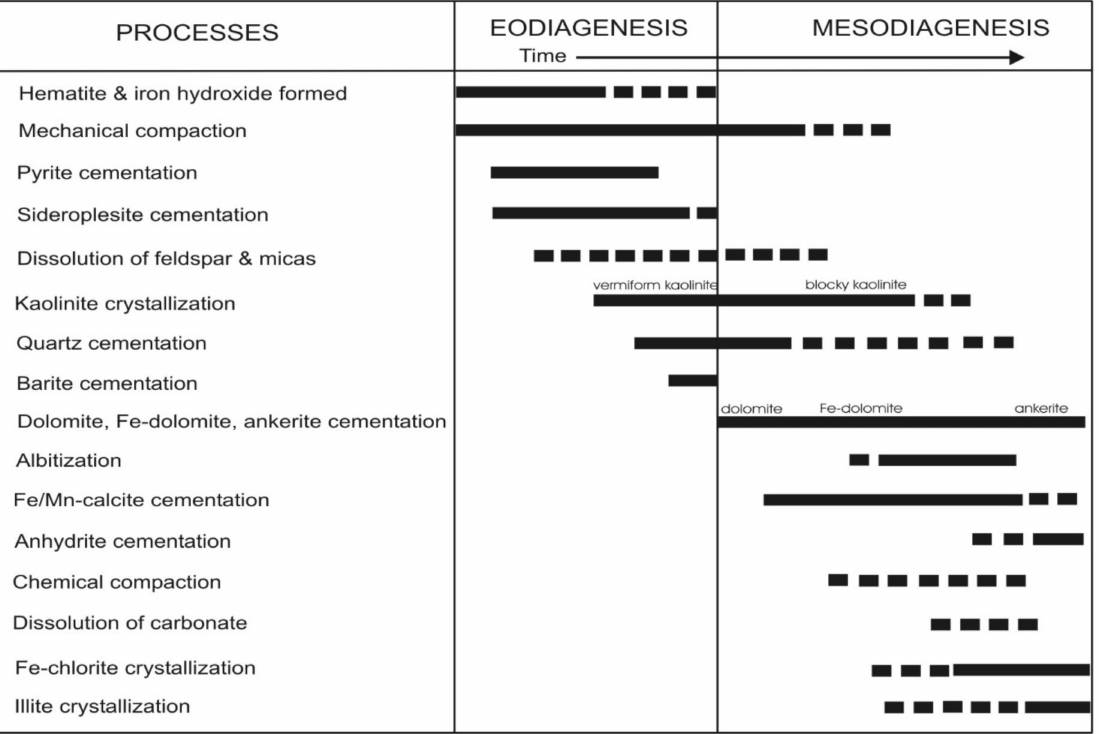
Figure 13. The synoptic paragenetic sequence of the Carboniferous